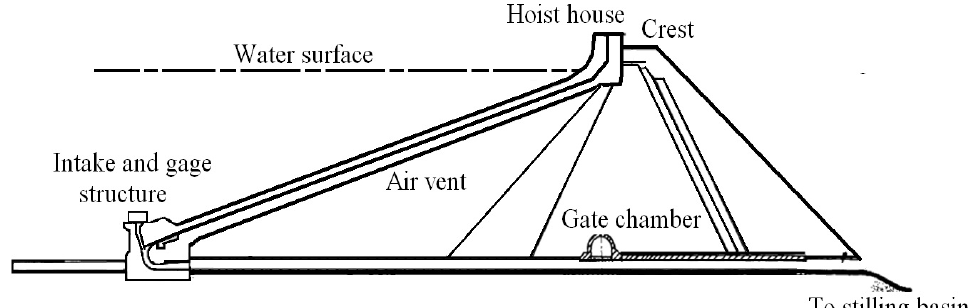
Figure 1. Typical representation of a low-level outlet works.